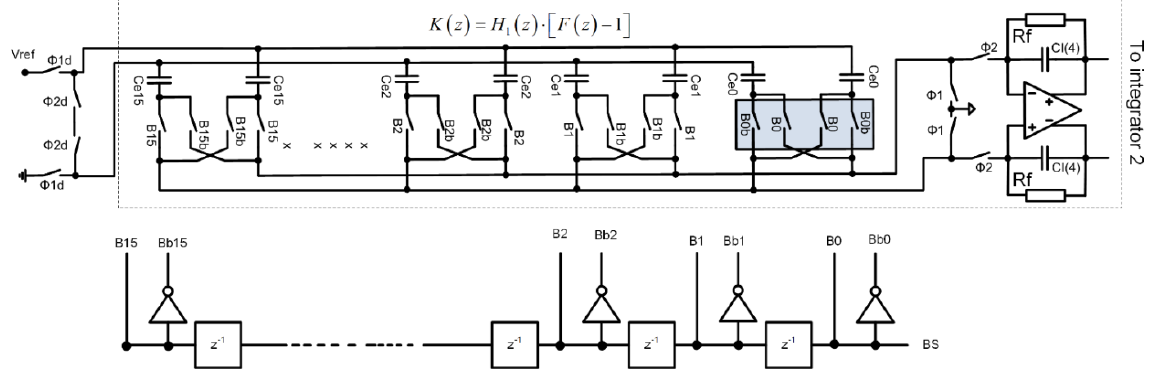
Figure 9. S-C implementation of compensation filter   K z with a switched capacitor